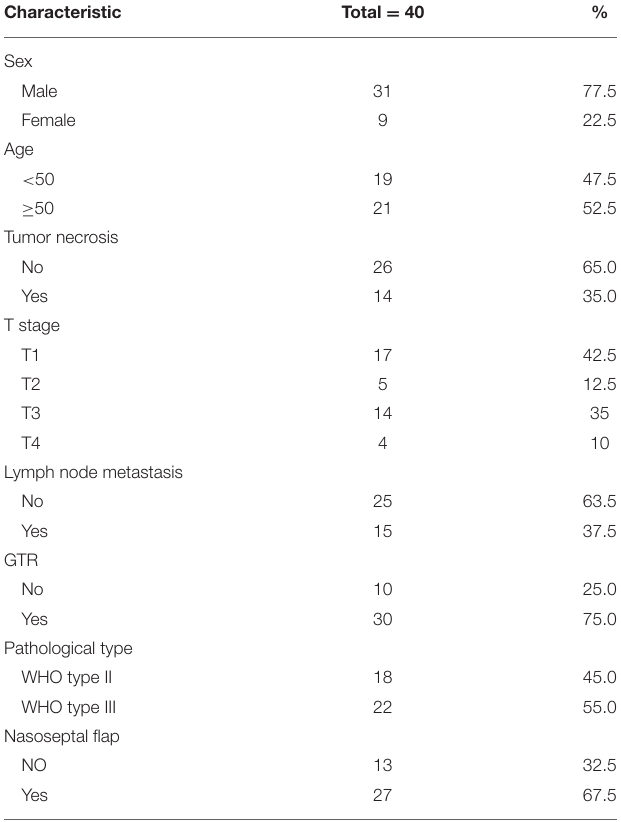
TABLE 1 | Summary of tumor characteristics in 40 patients who underwent endoscopic nasopharyngectomy. Characteristic